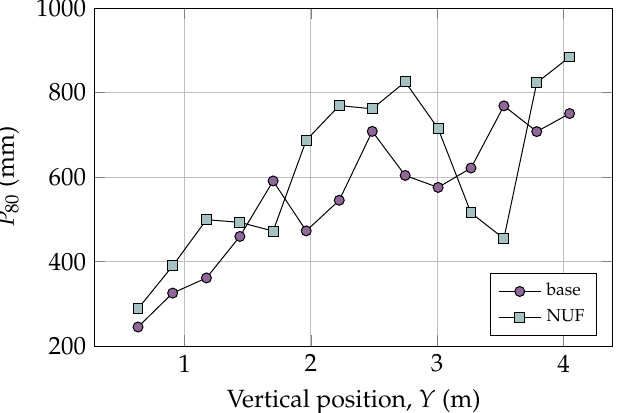
Figure 14. Eightieth percentile of the product size distribution vs. the vertical position of the particles in the crushing